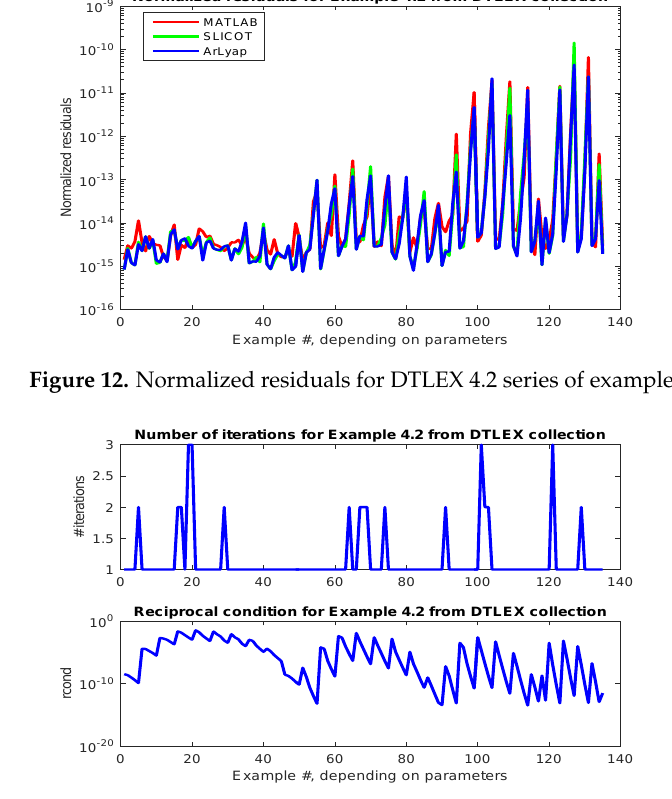
Figure 13. Number of iterations for ArLyap solver and reciprocal condition numbers for DTLEX 4.2 series of